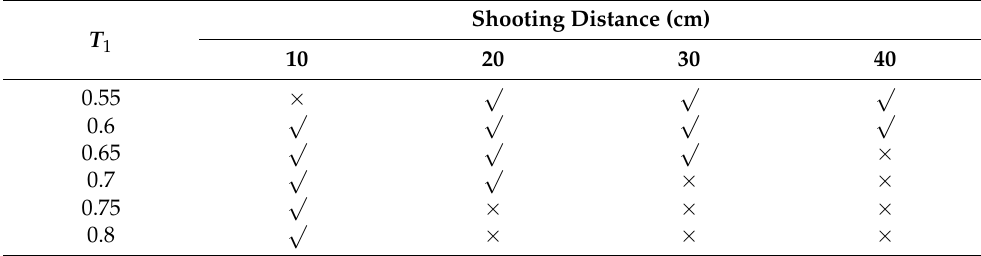
Table 2. Resynchronizing result of se with 7 × 7 Size.